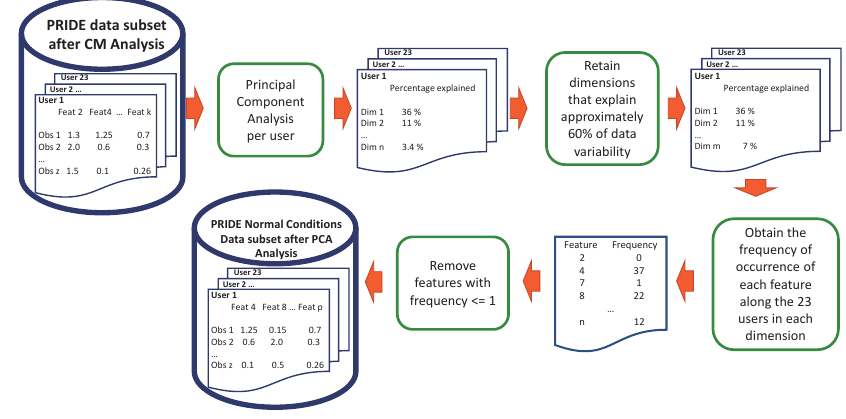
Figure 6. Feature selection process. Phase 2: PCA